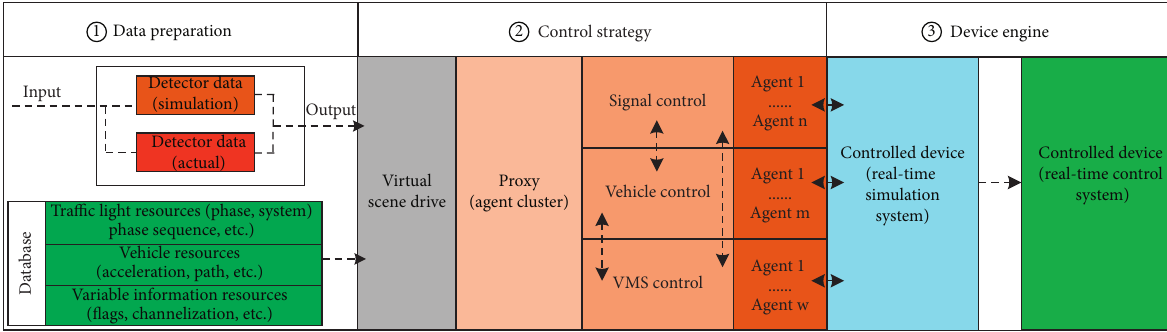
Figure 5: Control strategy API architecture of real-time simulation system.